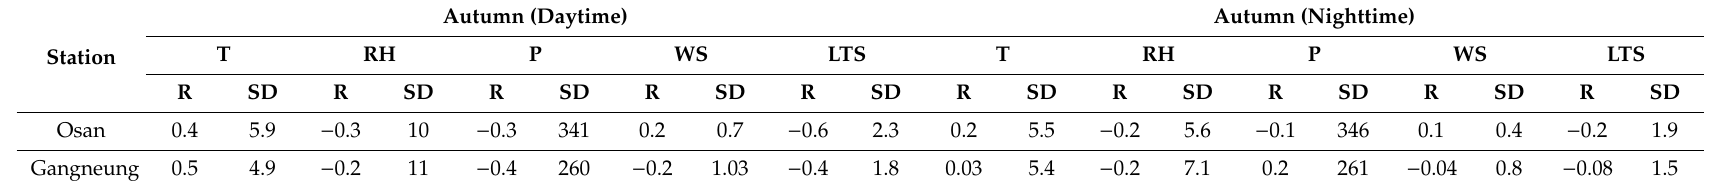
Table 4. Correlations between PBLH and meteorological parameters during